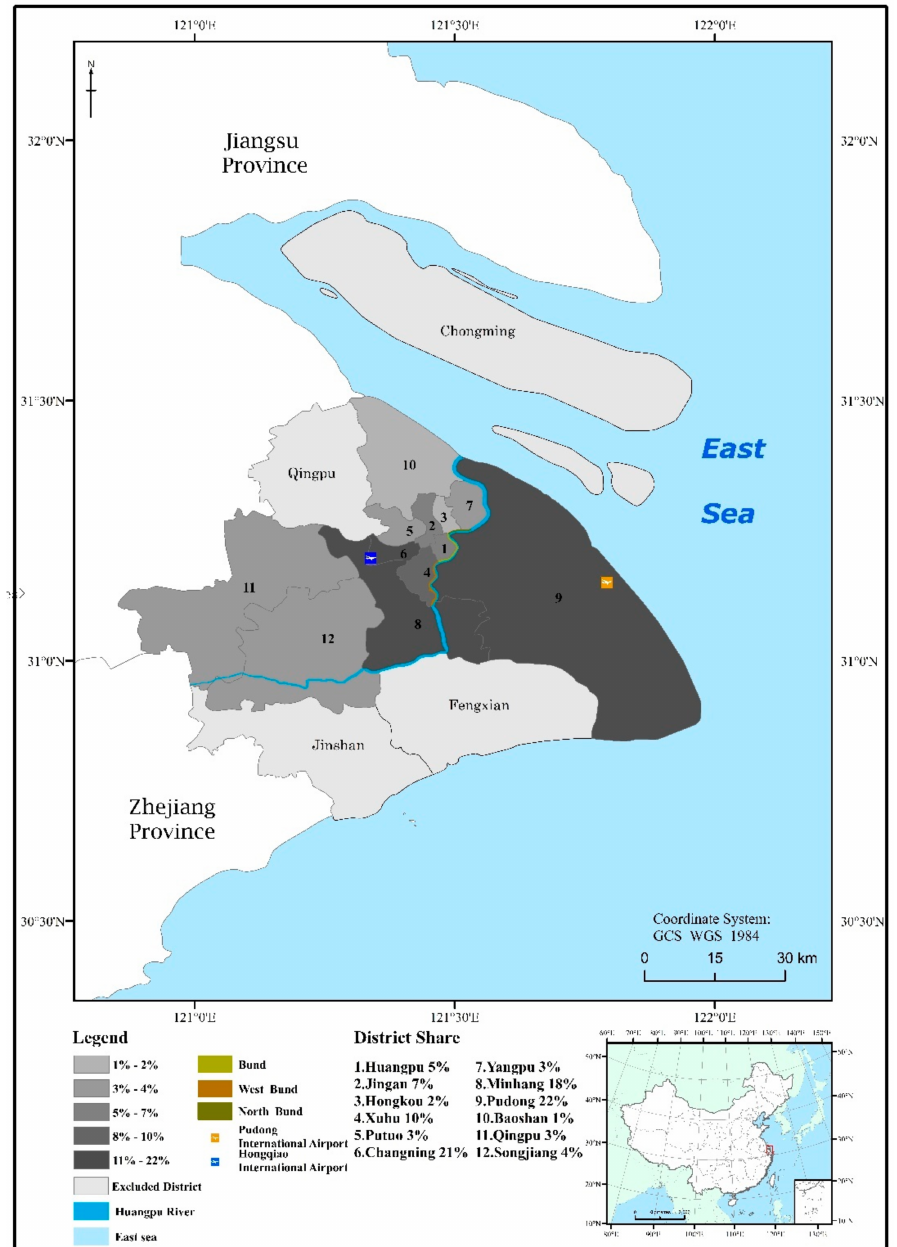
Figure 1. Proportion of foreign residents per district. Source: data derived from Shanghai Municipal- ity Statistical Bureau,